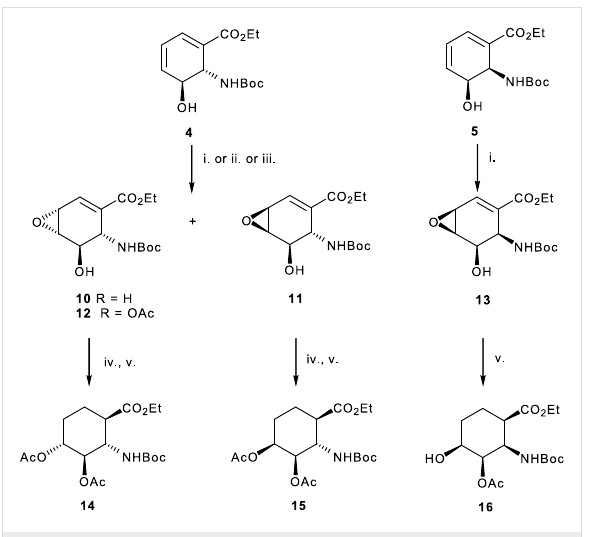
ping agents (e.g. TMSCl, TMSOTf) were partially